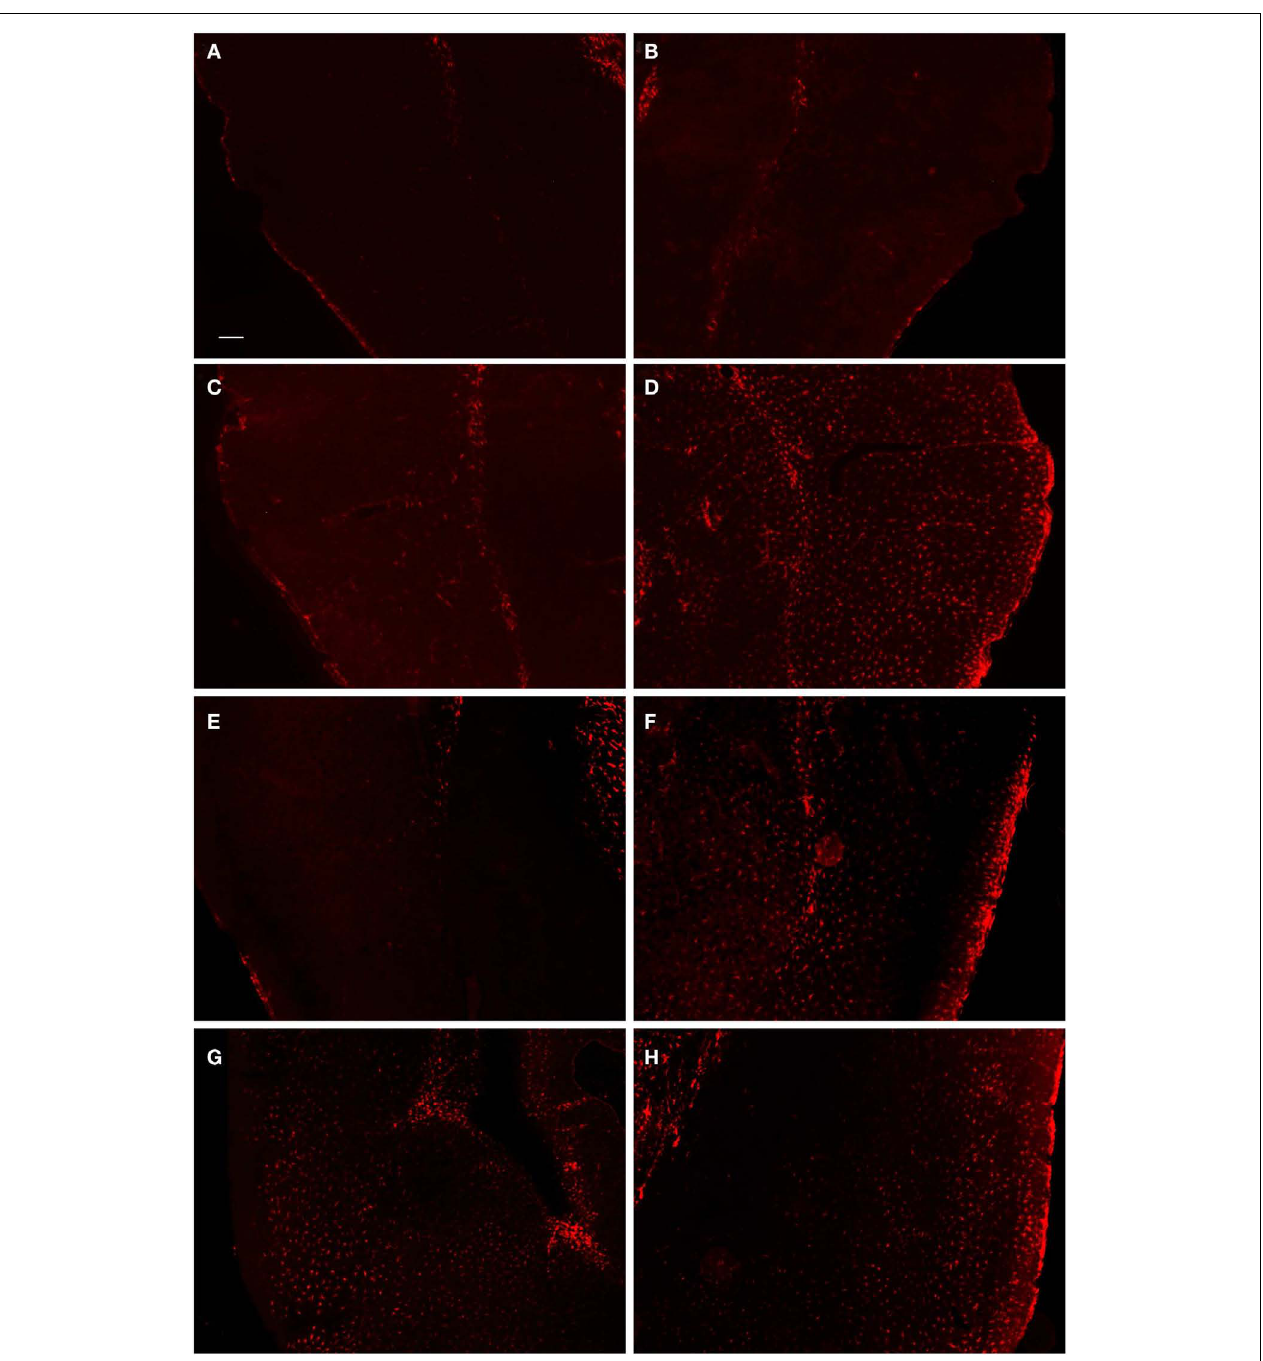
depletion of GFAP-labeling is observed.This is similar to the observation in Figure 3 (E,F) , in which the contralateral hemisphere corresponding to the lesion site also appeared depleted of GFAP-labeling. At 30days post-FPI (G,H) , GFAP-labeled astrocytes are widely distributed throughout both, ipsilateral (G) and contralateral (H) hemispheres. Note, that we have also provided light microscopic images of DAB-reacted tissue ( Figure 5 ) demonstrating these same observations. Scale bar in (A) = 50 µ m for all